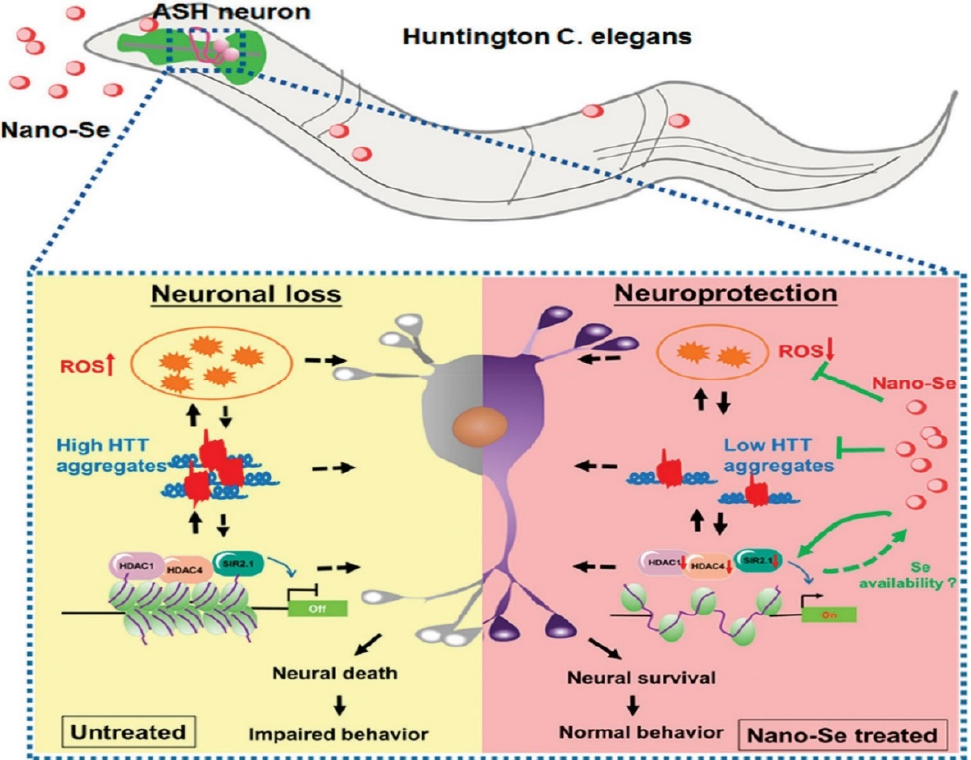
Figure 4. Schematic diagram of the neuroprotective effect of nano-Se in a model of C. elegans HD. Reproduced with permission [116]. Copyright 2019 The American Chemical Society.